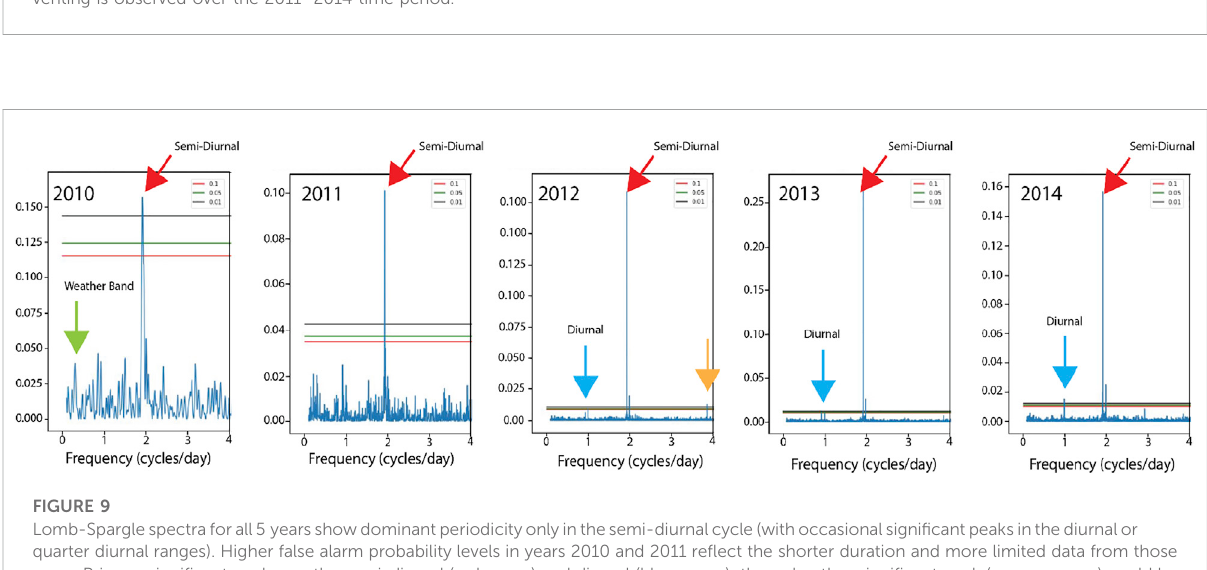
FIGURE 8 The cumulative backscatter observed along the plume centerline from 2 m above the vent to 18 m above the vent. No signi fi cant change in venting is observed over the 2011 – 2014 time